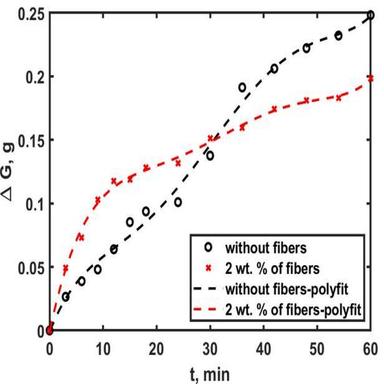
Mass loss during cavitation experiments for two samples together with the 5th degree polynomial fit that enables data smoothing for further analysis. The R2 was 0.996 for the sample with 2 wt % of fibers while for the sample without fibers it was 0.993.